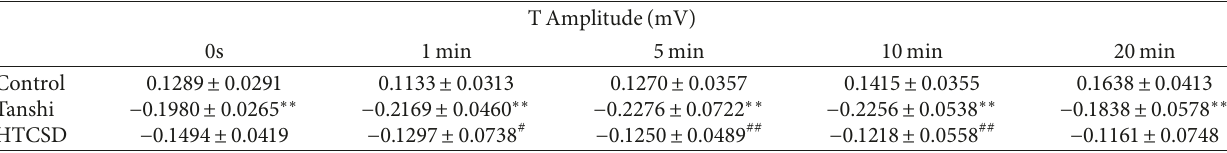
Table 2: Changes of T wave in the ECG of mice (mean ± S .D, n �